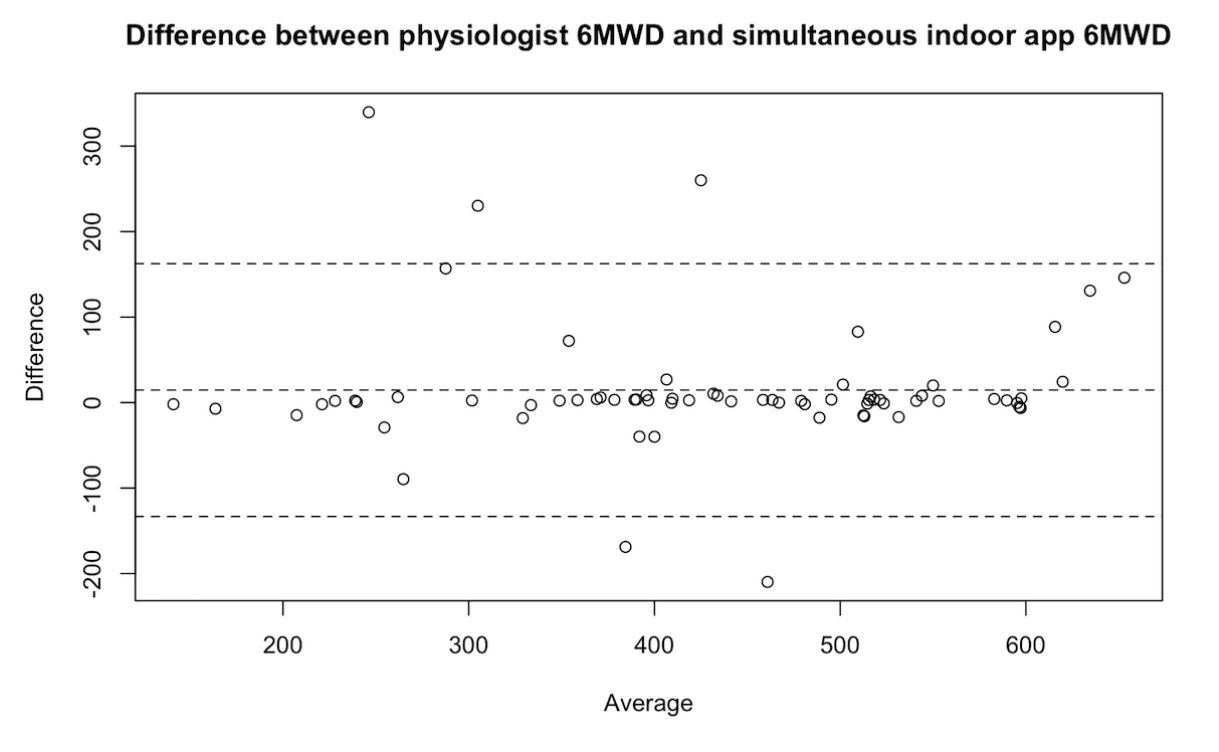
Figure 2. Bland-Altman plot of the difference between the 6-minute walk test distance as measured by the app in indoor mode and as observed by the